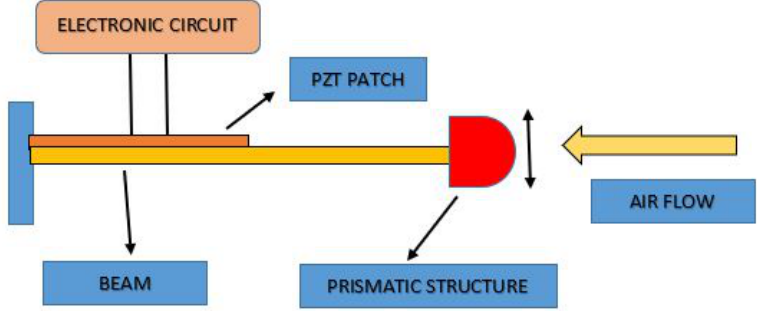
Figure 11. Transverse galloping-based PEH schematic. A D-shaped prismatic structure is subjected to airflow, attached at the end of an elastic cantilever beam.